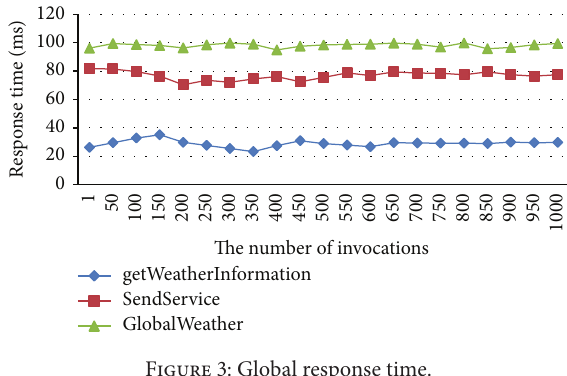
Figure 3: Global response time.